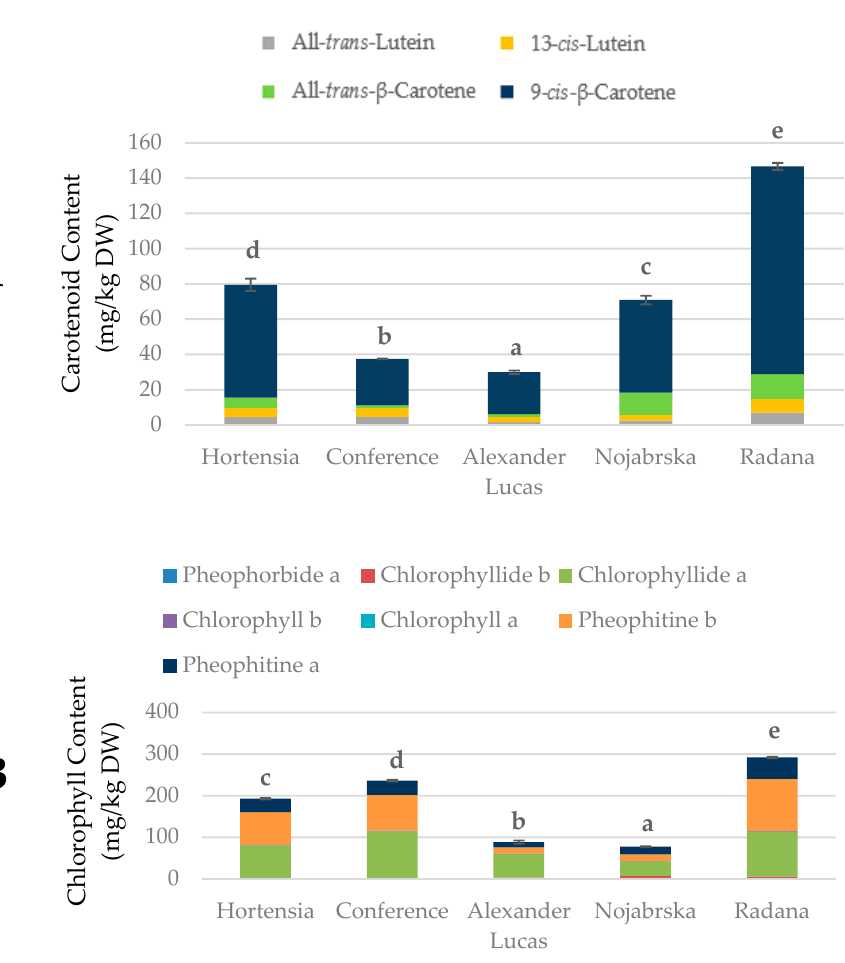
Figure 4. Contents of the ( A ) carotenoids and ( B ) chlorophylls (mg / kg DW) in pear cultivars. Varieties with di ff erent letters were significantly di ff erent at p = 0.05 according to Duncan’s test. The data are expressed as mean ± SD ( n = 9).